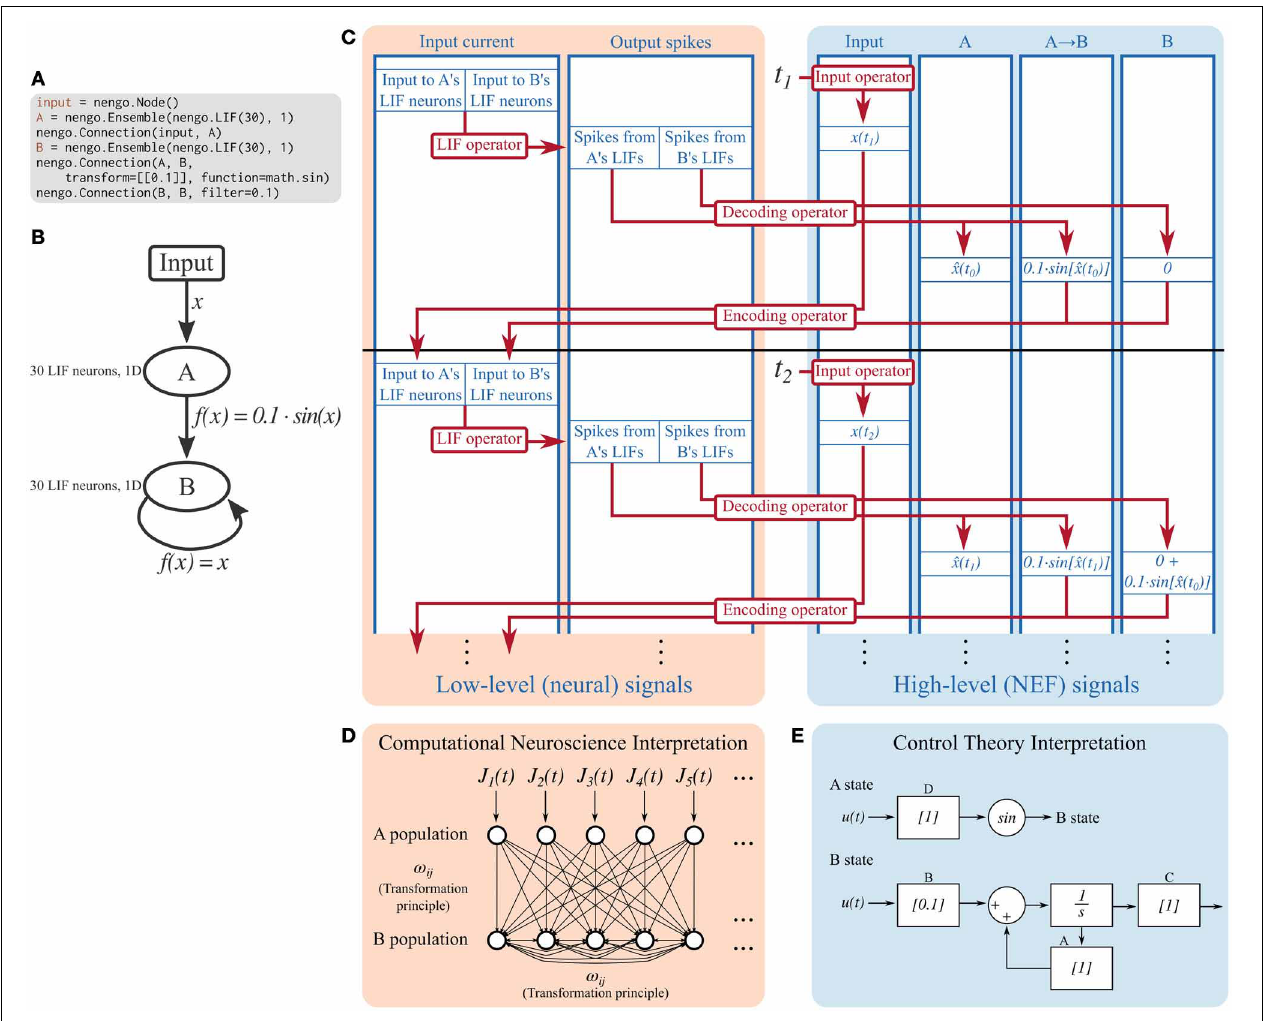
FIGURE 2 | Detailed breakdown of the Nengo reference simulator running a simple model for two timesteps. (A) Code describing the model being simulated. It consists of ensemble A projecting the sine of its encoded signal to ensemble B, which is recurrently connected. (B) Diagram depicting the model being simulated. (C) A detailed diagram of how the reference simulator organizes this model. Signals (blue) represent the values tracked in the simulation. Operators (red) represent the computations done on signals. Signals can be grouped as low-level neural signals that are used to compute the non-linear functions underlying neuron models, and high-level NEF signals that are used to drive neurons and track the signals that the neurons are representing. The operators that implement the decoding and encoding steps map between the low-level neural signals and the high-level NEF signals. (D) The signals tracked at the low level can be interpreted as a